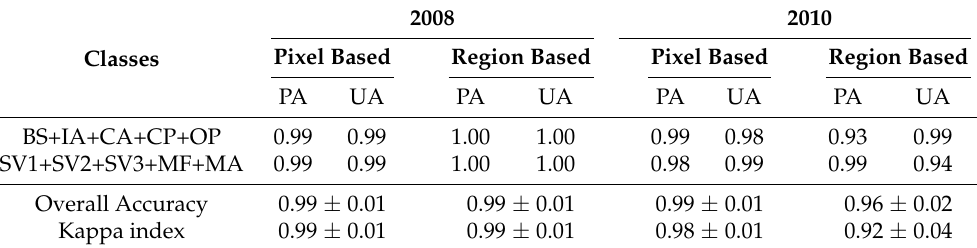
Table 11. Mean accuracy values of land cover classes of L3 based land cover